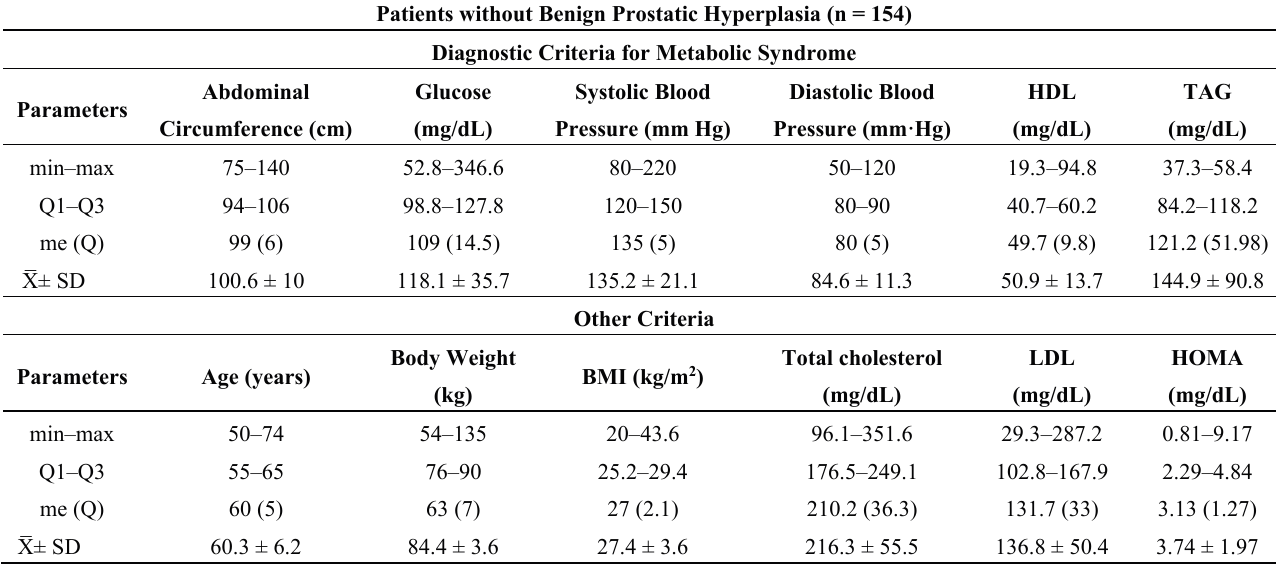
Table 3. Selected statistical parameters of the diagnostic criteria of metabolic syndrome and additional parameters in patients without benign prostatic